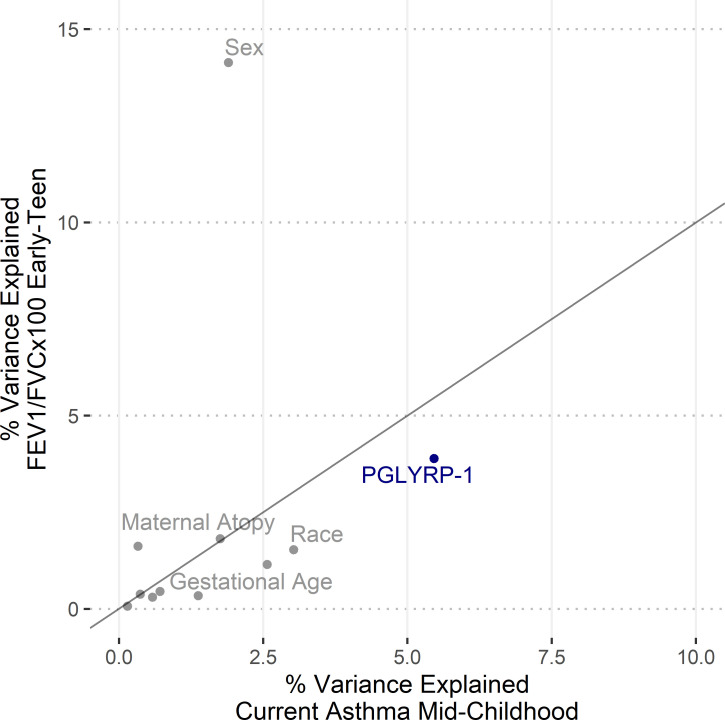
Relative importance of predictors for pediatric asthma and FEV1/FVC.Relative importance, displayed as percent of variance explained, for variables used in regressions (Table 3, model 3) for current asthma at mid-childhood and FEV1/FVC in early-teen years. Variance estimated for logistic regression as Mcfadden’s pseudo-R (Jaakkola et al., 2006).